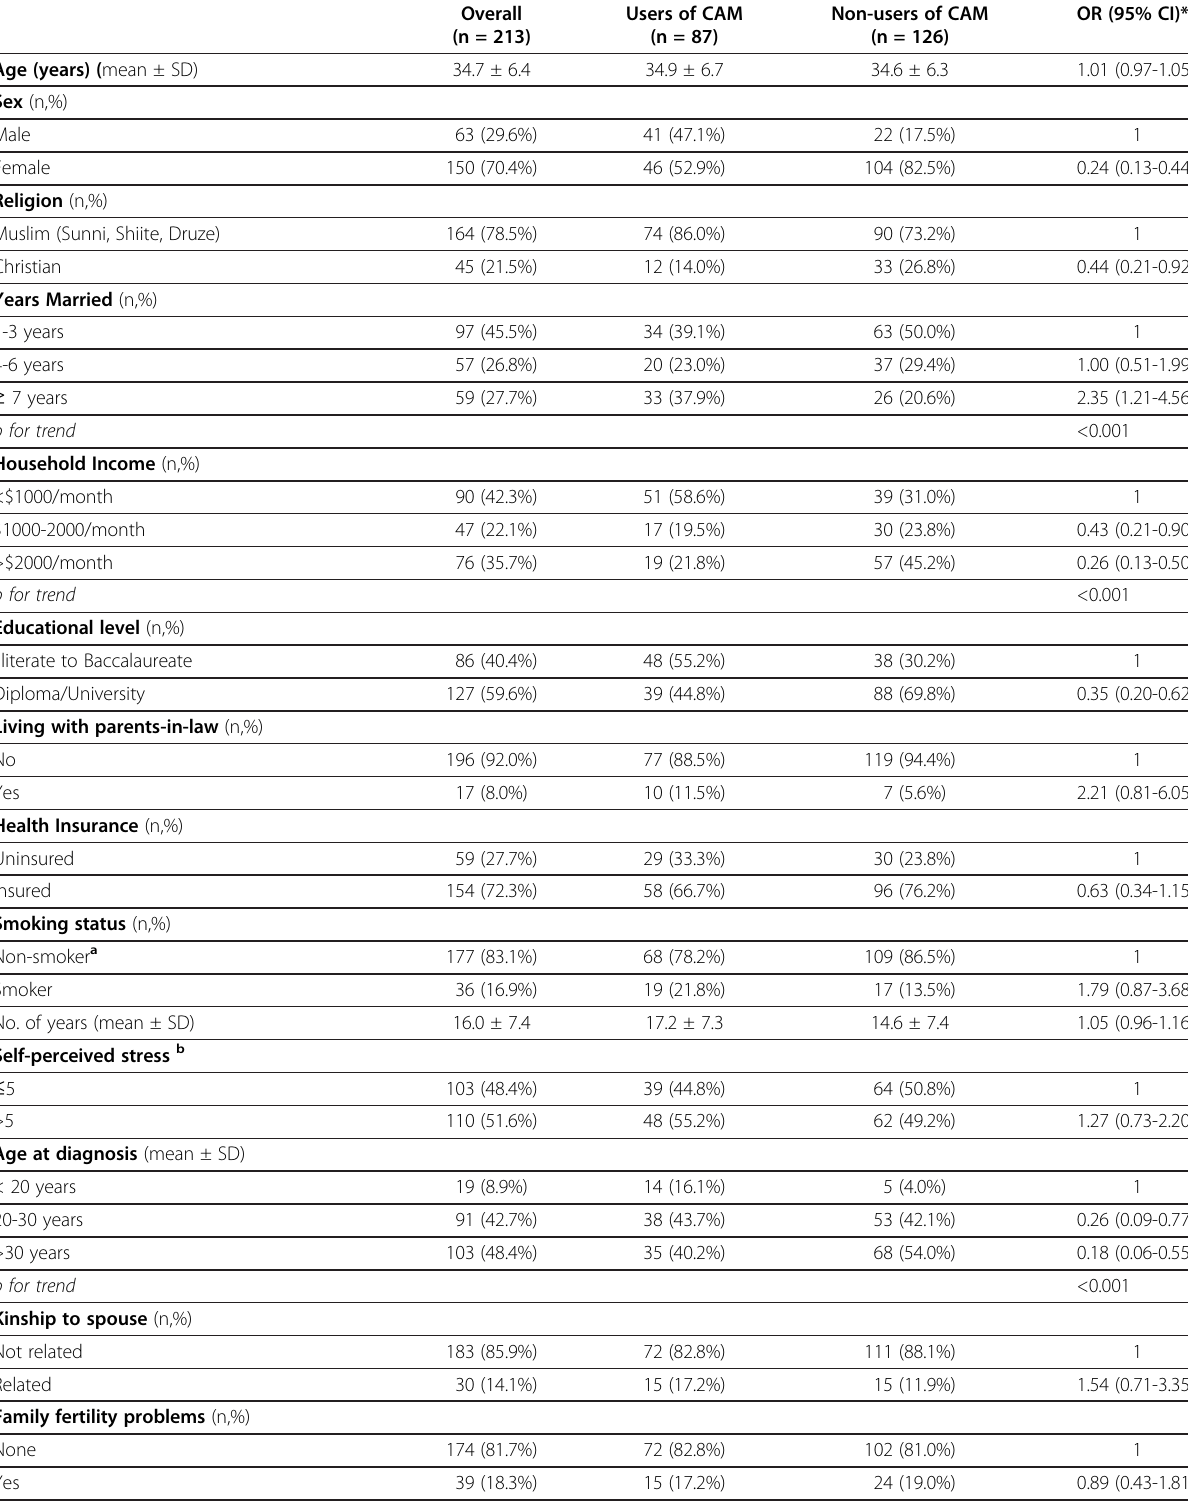
Table 1 Demographic, lifestyle, reproductive and infertility-related characteristics of users and non-users of CAM